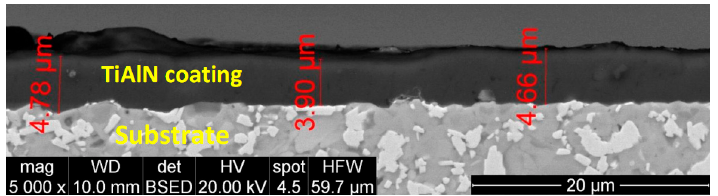
Figure 5. Structure on cross-section of coating TiAlN, with thickness 4 (±0.8) µm.